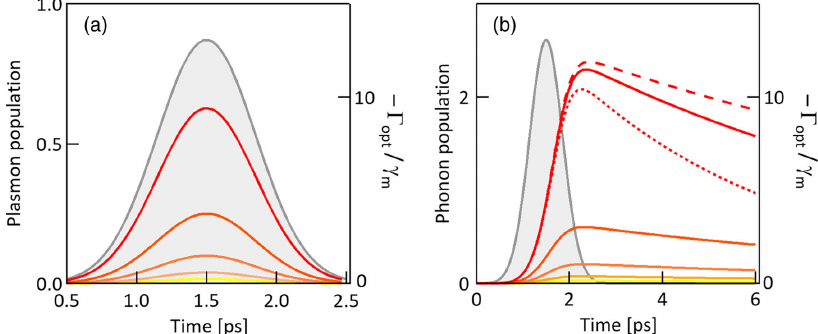
FIG. 14. Evolution of the optomechanical SERS system excited by a 1-ps Gaussian pulse. (a) Evolution of plasmon population for five peak intensities of the incident laser, logarithmically increasing from 6 × 10 2 μ W = μ m 2 (yellow line) to 2 . 5 × 10 4 μ W = μ m 2 (red line). ð t Þ = γ The shaded area shows normalized optomechanical damping − Γ , proportional to the instantaneous intensity of the incident m opt ð t Þ is negative, indicating that the system operates in the amplification regime. The plasmonic cavity reacts almost pulse. Γ opt instantaneously to the coherent pump, with the plasmon population closely following the shape of the incident pulse. (b) Phonon population calculated in the same setup, obtained by solving the phonon rate equations. For the largest incident laser intensity, we ¼ 0 . 07 meV is used for all the solid lines, while ℏ γ ¼ 0 . 14 meV consider three values of the free-space phonon decay rate: ℏ γ m m ¼ 0 . 045 meV (dashed) are also plotted. In all the cases, the buildup of phonons is much slower than that of plasmons, (dotted) and ℏ γ m as the vibrations do not reach a steady state during the duration of the pulse. All the remaining parameters are as discussed in the